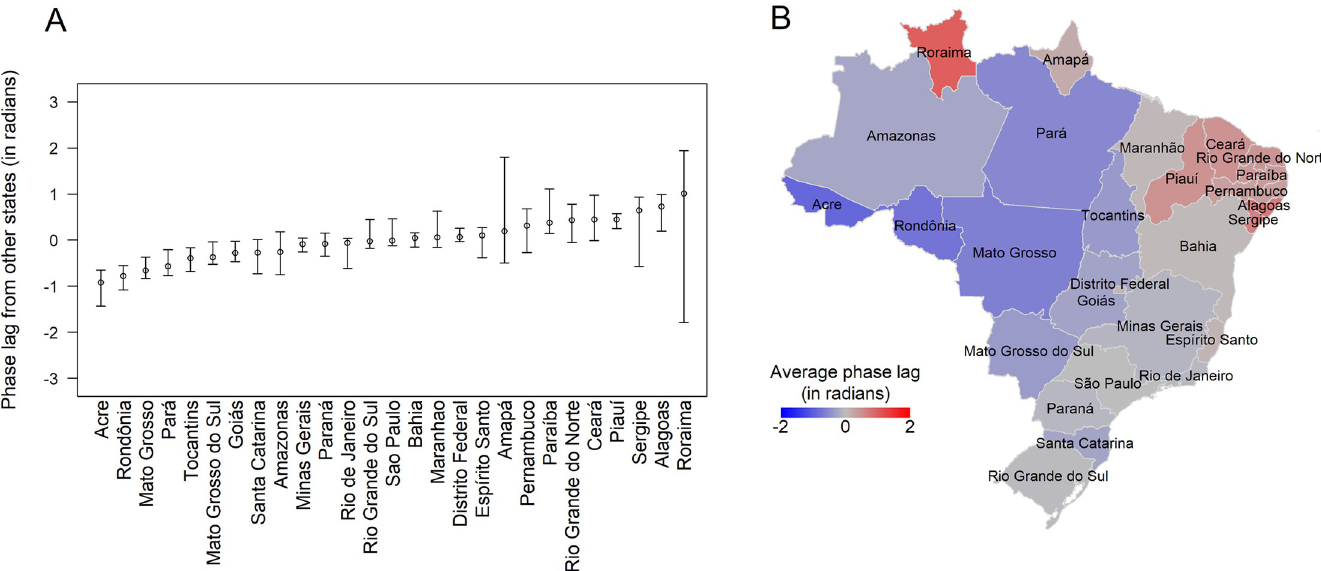
Fig 2. Average phase lags of seasonal dengue between Brazilian states. (A) For each state, median and 95% range of annual phase lags from other states over the study period. States were ordered by their median phase lag. (B) Map of the relative timing of annual dengue waves, which was defined using the average annual phase lag of each state from every other state. Administrative boundaries were obtained from GADM (https://gadm.org).